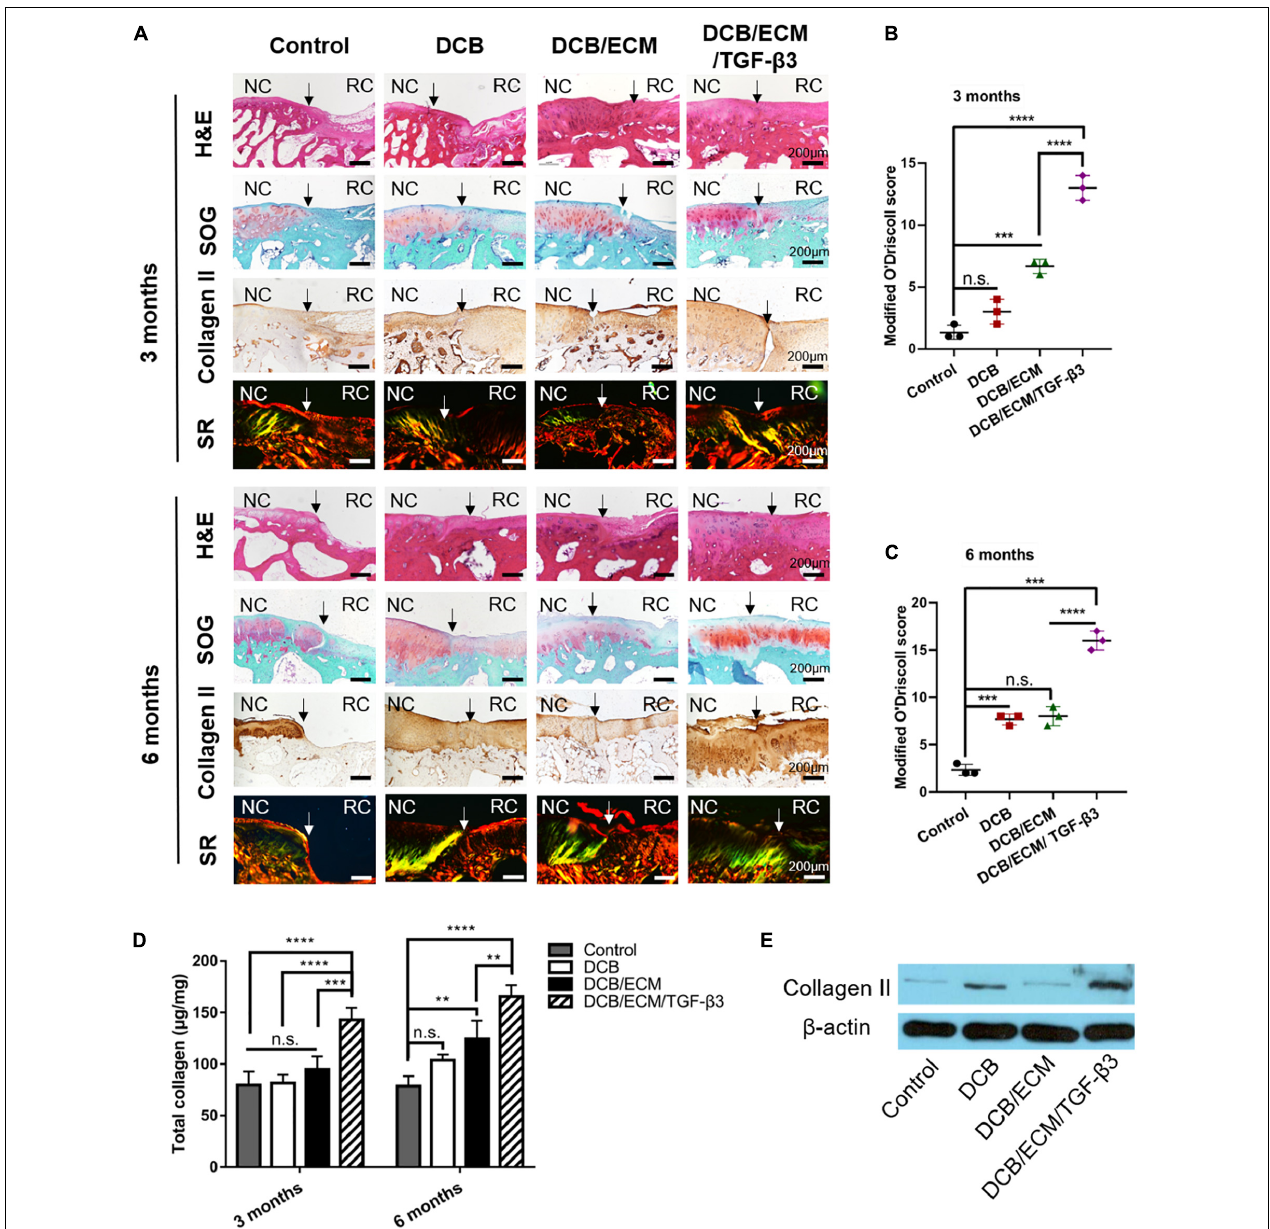
FIGURE 7 | Histological and biochemical evaluation of repaired tissue. (A) Representative H&E, safranin O/fast green (SOG), collagen II and picrosirius red (SR) staining of repaired knees at 3 and 6 months ( n = 6 knees). Staining was repeated twice or more independently. Modified O’Driscoll scoring for cartilage evaluation at 3 months (B) and 6 months (C) ( n = 3 knees). (D) Total collagen contents of repaired knees at 3 and 6 months ( n = 3 knees). (E) WB analysis of collagen II in repaired tissues at 6 months. NC, normal cartilage; RC, regenerated cartilage. Data are means ± SDs (** p < 0.01, *** p < 0.005, **** p < 0.001, n.s. represents no significant